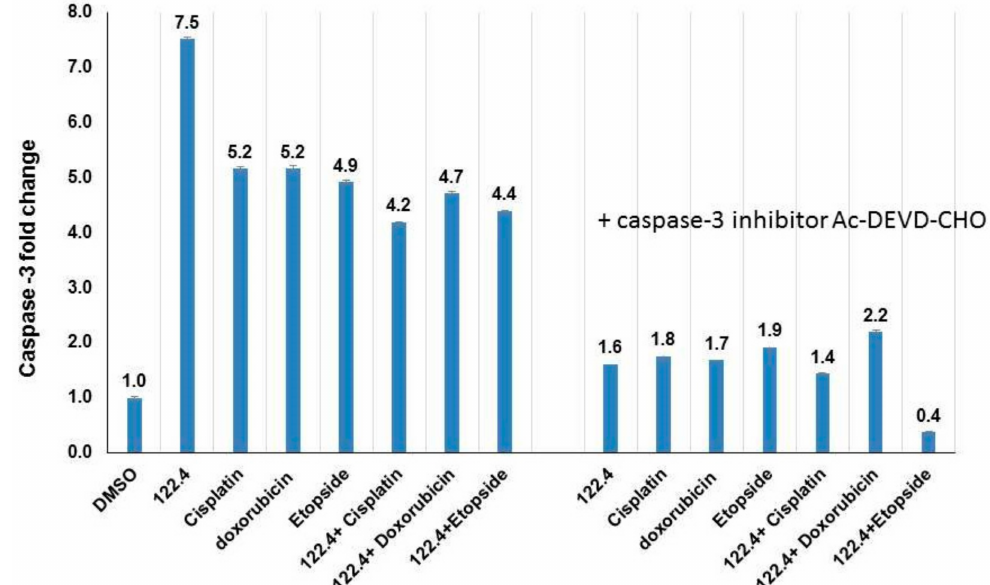
Figure 4. Induction of Caspase-3 activity in BS-24-1 cells with single and combined treatments. 3 × 10 6 cells/mL were treated overnight with 100 µ g/mL of 122.4 or doxorubicin or etoposide or cisplatin as single treatment or with 50 µ g/mL each as combined treatment. In order to assure that caspase-3 is the induced enzyme, cellular extracts were pre-incubated with caspase-3 inhibitor Ac-DEVD-CHO for 10 min before adding the substrate for the caspase-3 assay. Y axis presents folds induction as compared to incubation with the solvent